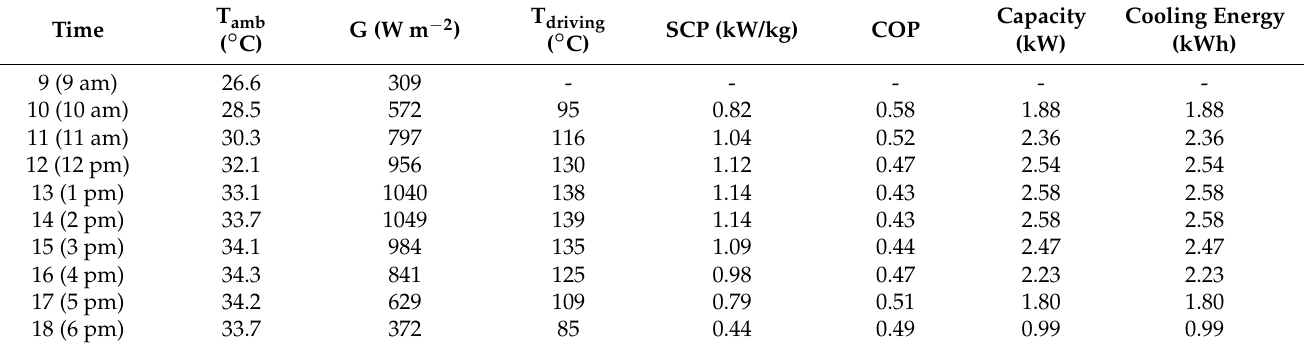
Table 6. Air conditioning performance with ETSC (A col = 9.8 m 2 ) on the hottest day (5 April).